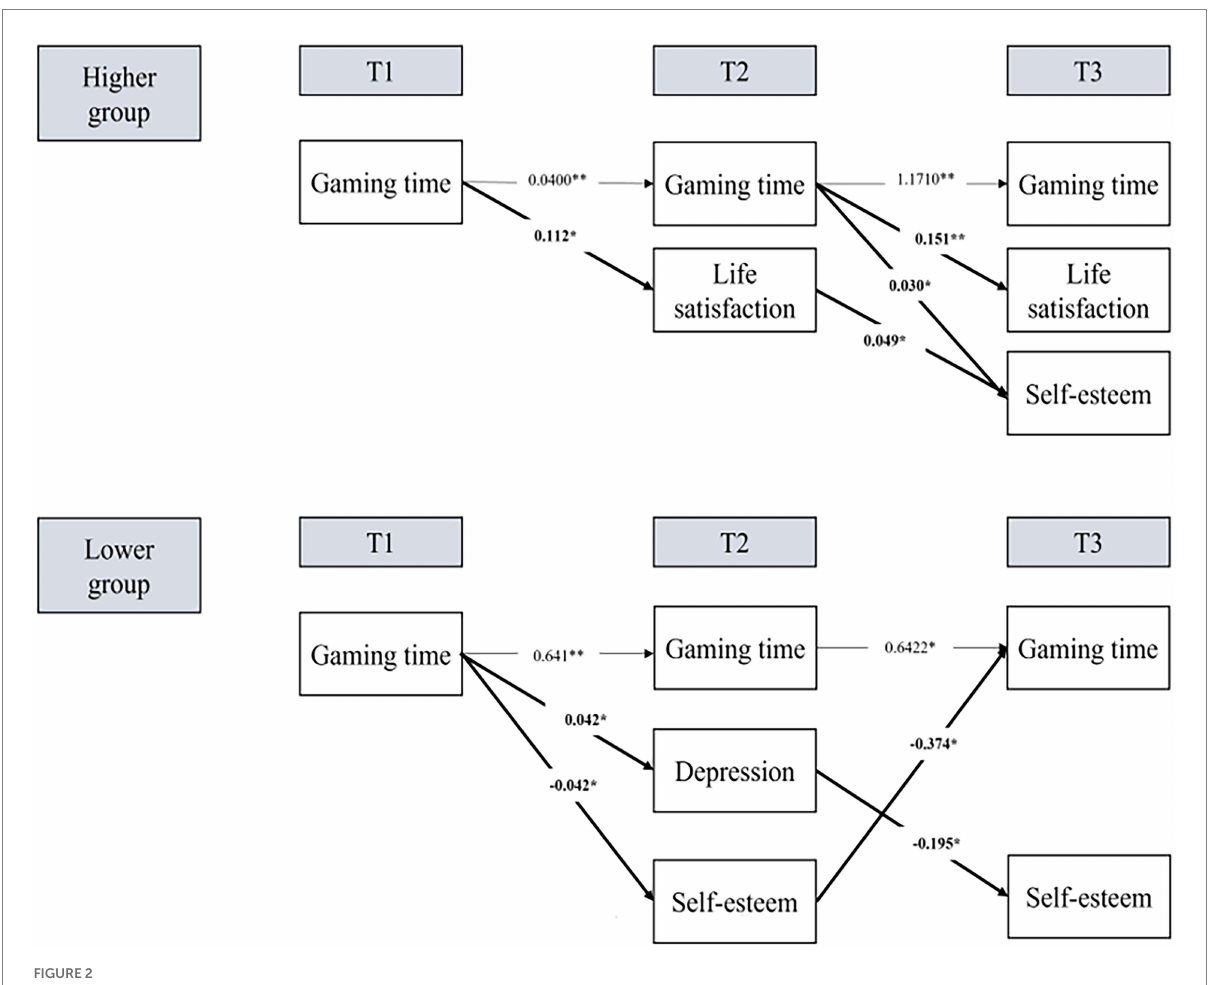
FIGURE 2 Two-group structural equation